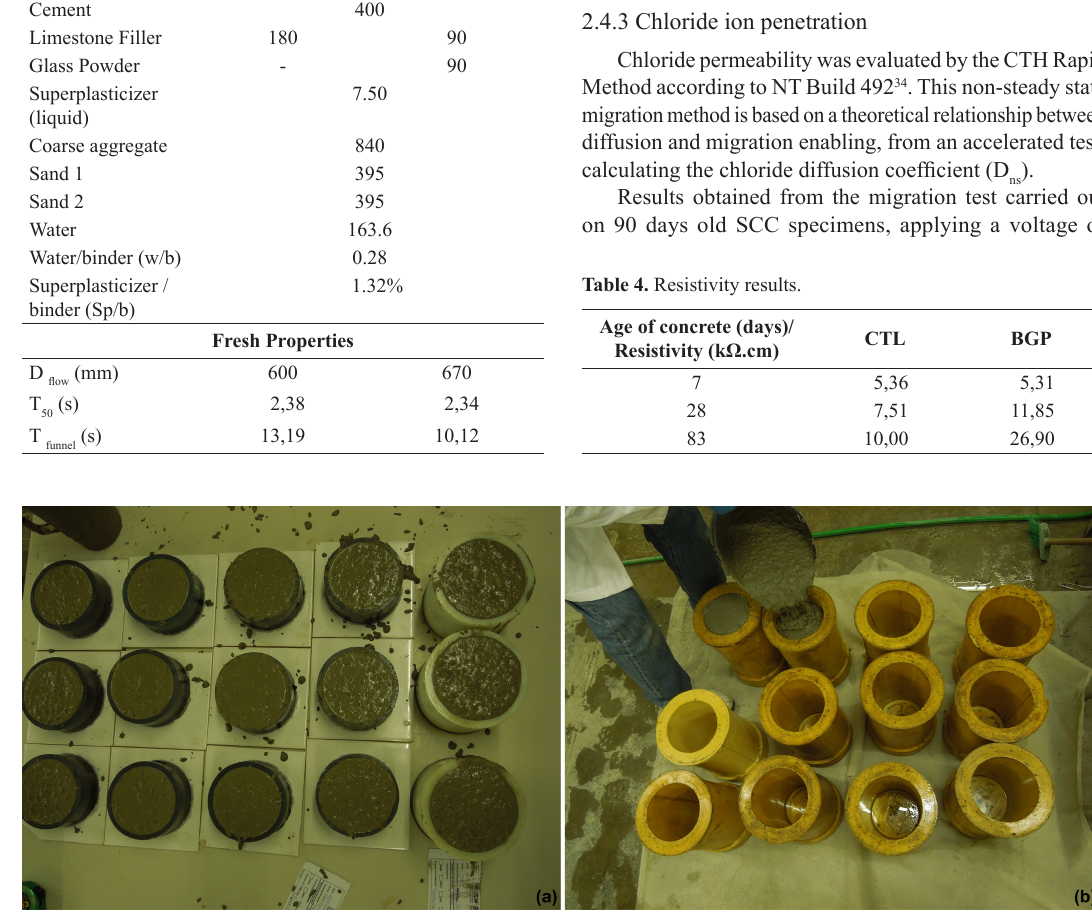
Figure 6. Test specimens.